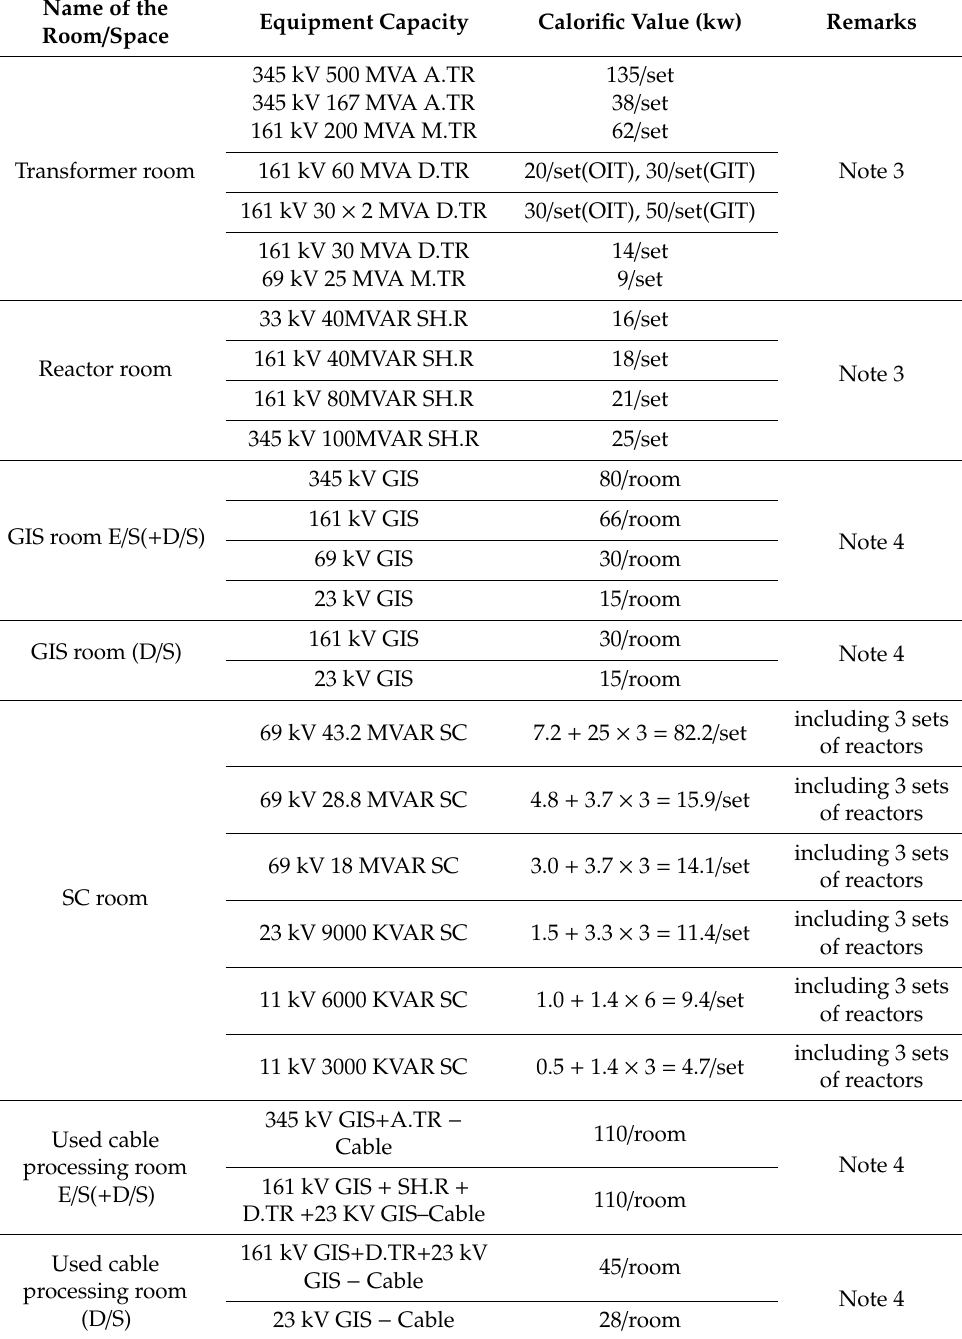
Table 2. Calorific values for electromechanical equipment in a